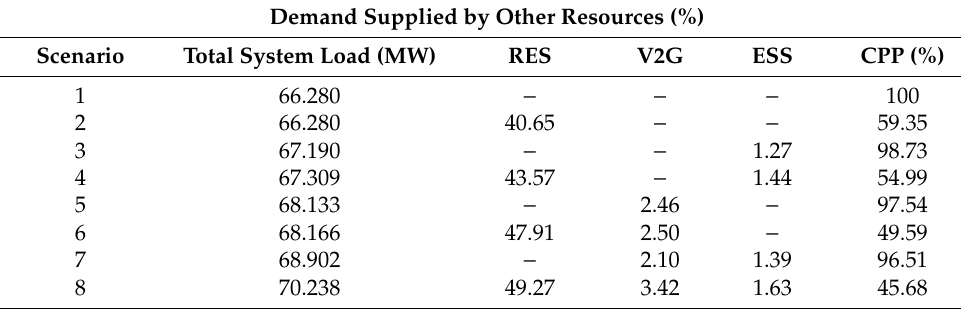
Table 9. The contribution of each resource in supplying total 24-hour electrical demand.